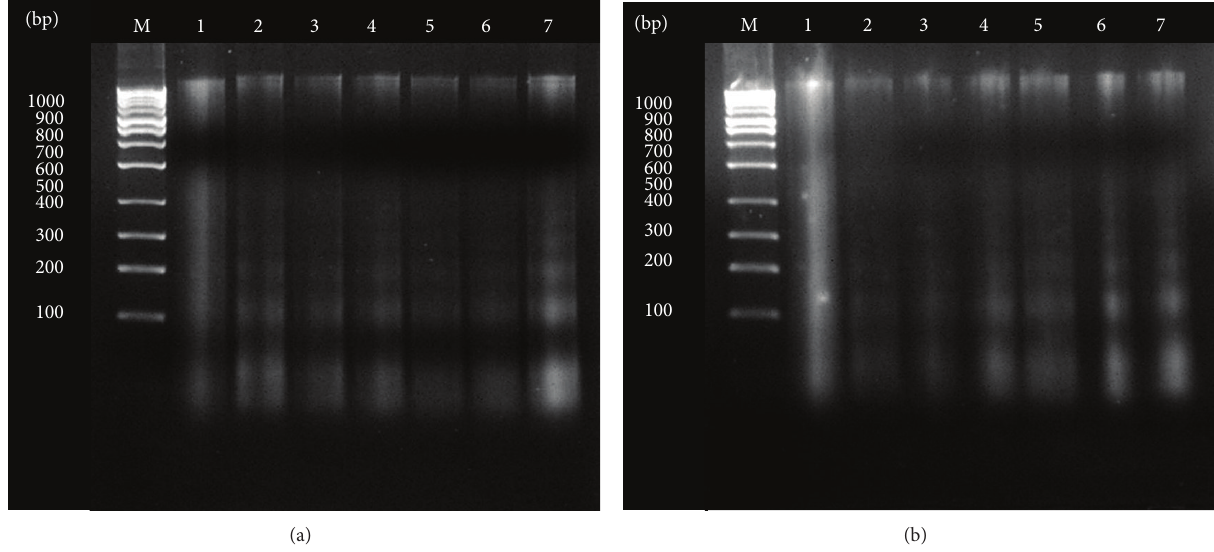
Figure 4: DNA band patterns of (a) KB and (b) ORL-48 cells treated with various concentrations of Brucea sp. Lane 1: negative control; Lanes 2 to 7 were bands of cancer cells treated with 1.0, 10.0, 25.0, 50.0, 75.0, and 100.0 𝜇 g/mL extract of Brucea